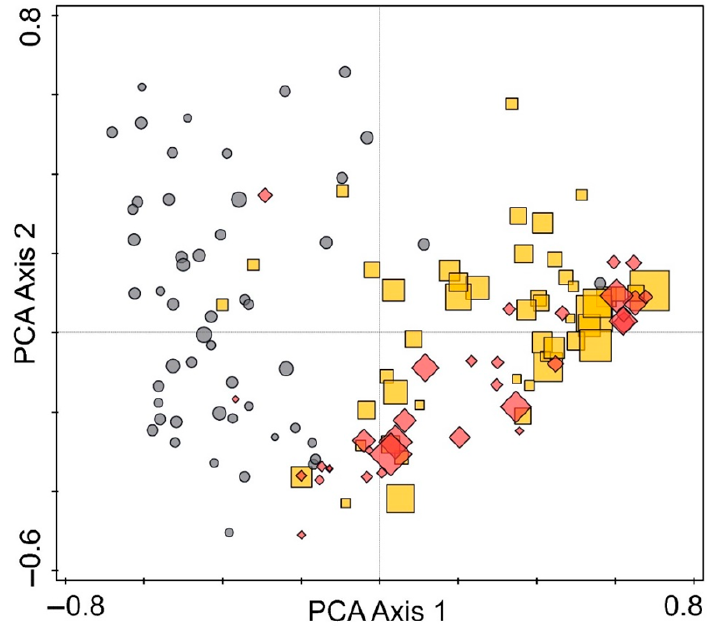
Figure 8. Ordination diagram based on principal coordinate analysis (PCA) of fungal communities from fungal spore traps collected between September 2017 and August 2018 at Labanoras (Orange), Dubrava (Grey), and Lenkimai (Pink) sites. Each point in the diagram represents a single sample and the size of each point reflects the relative richness of fungal taxa.